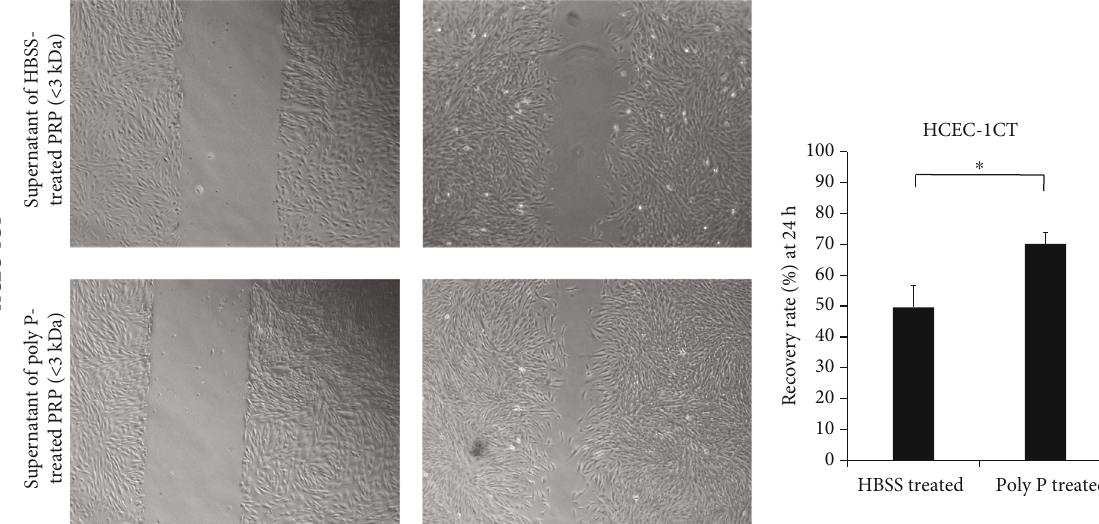
Figure 6: Poly P induced the expression of low-molecular weight mediators, which exerted wound healing e ff ects, by platelets. The supernatant of poly P-treated PRP separated by the 3 kDa MWCO column exerted a wound healing e ff ect. The error bars and numbers show the standard deviation. ∗ P < 0 : 05 by Student ’ s t -test.